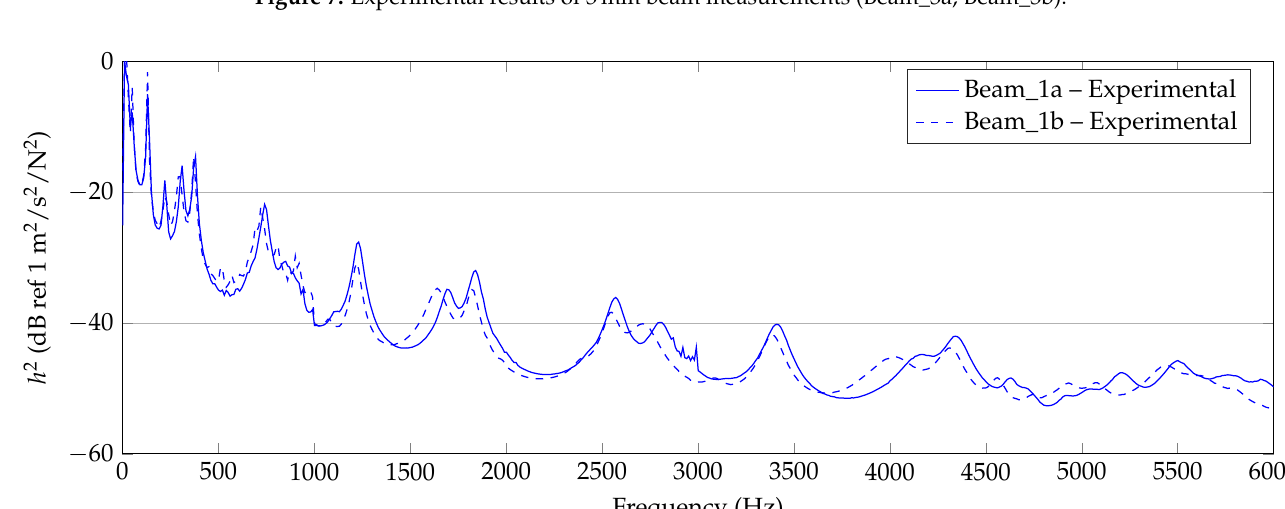
Figure 7. Experimental results of 3mm beam measurements (Beam_3a, Beam_3b).